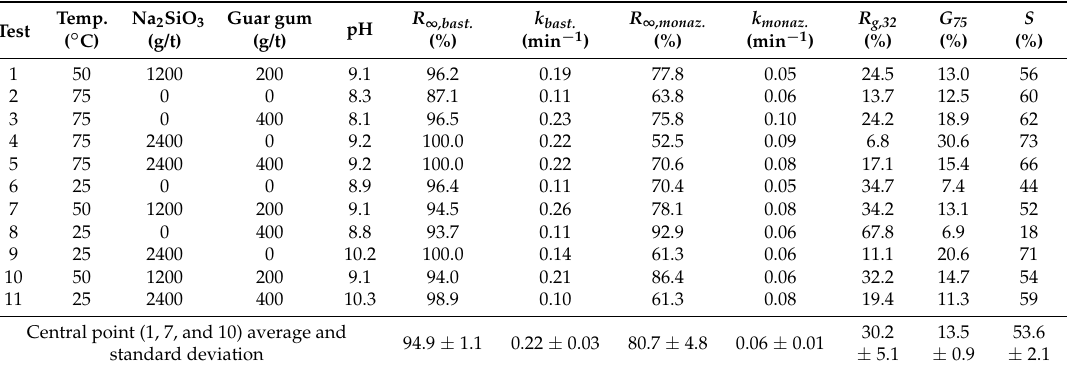
Table 7. Conditions and results of flotation tests.